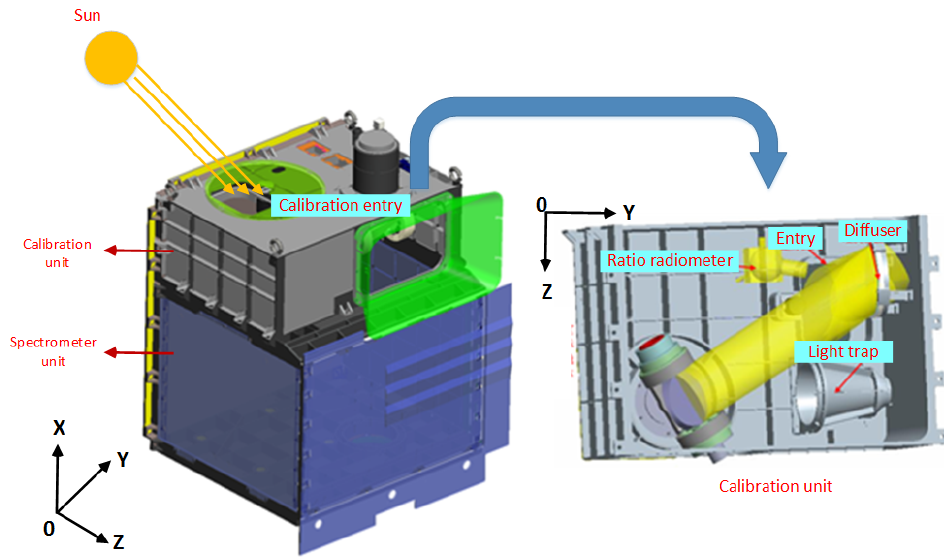
Figure 5. Calibration unit of the GMI.